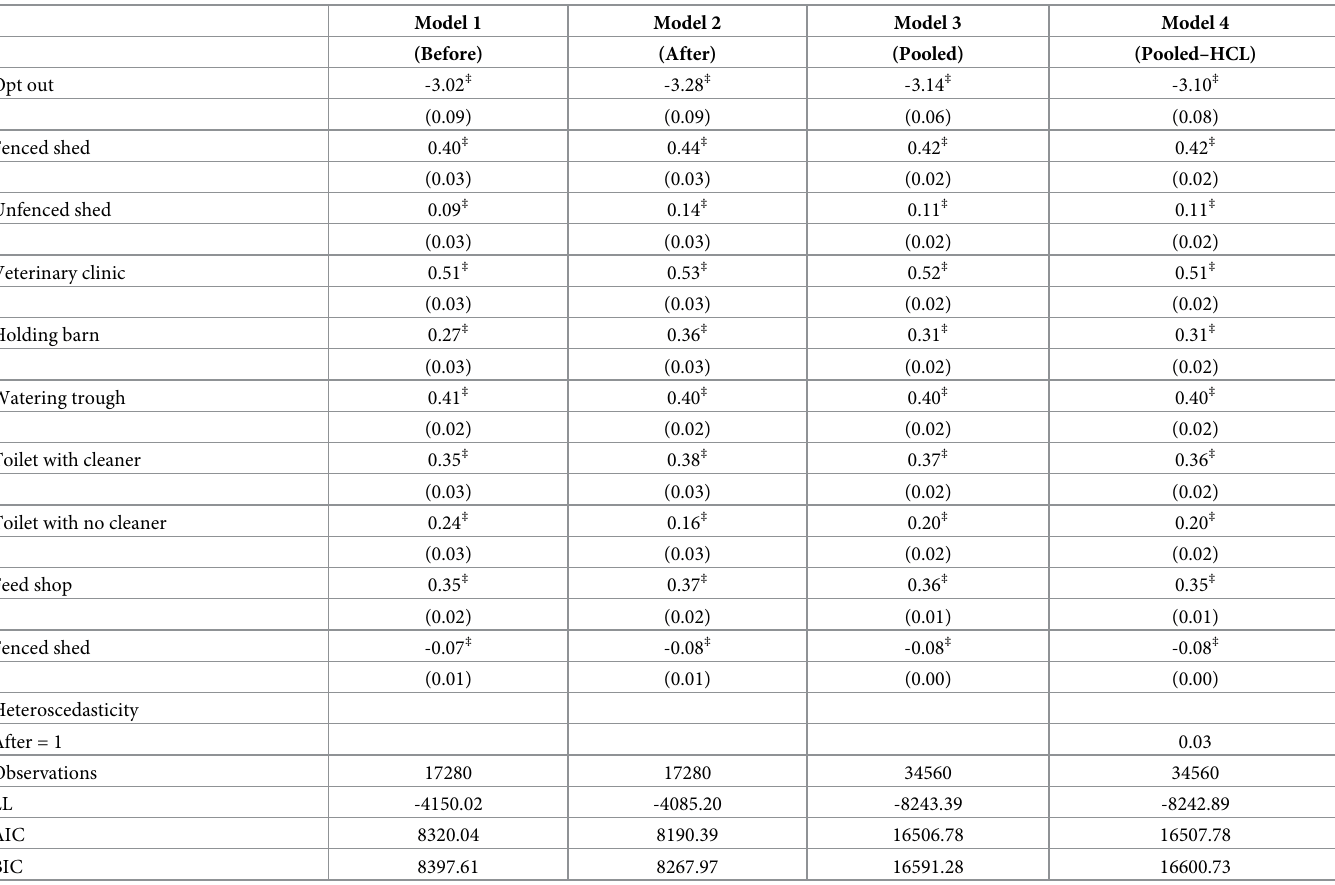
Table 3. Taste parameter estimates–CL model